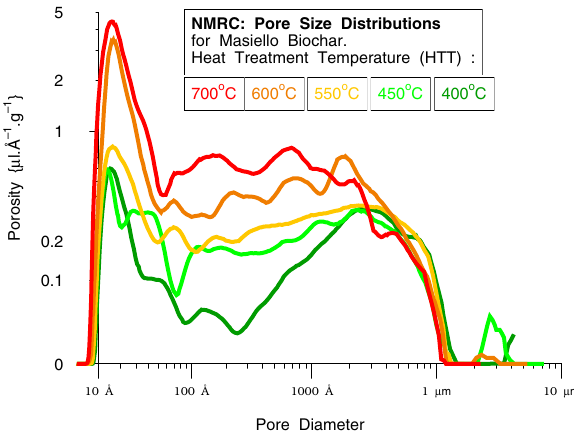
Fig. 24 NMR cryoporometric measurements on five biochars, with different heat treatment temperatures (HTTs)